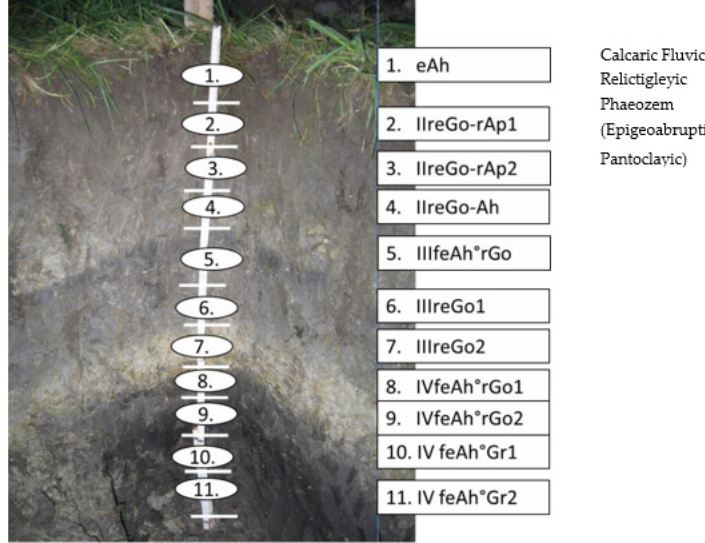
Table 2. Chemical properties and particle size distribution of the soil profile Pulling 8.